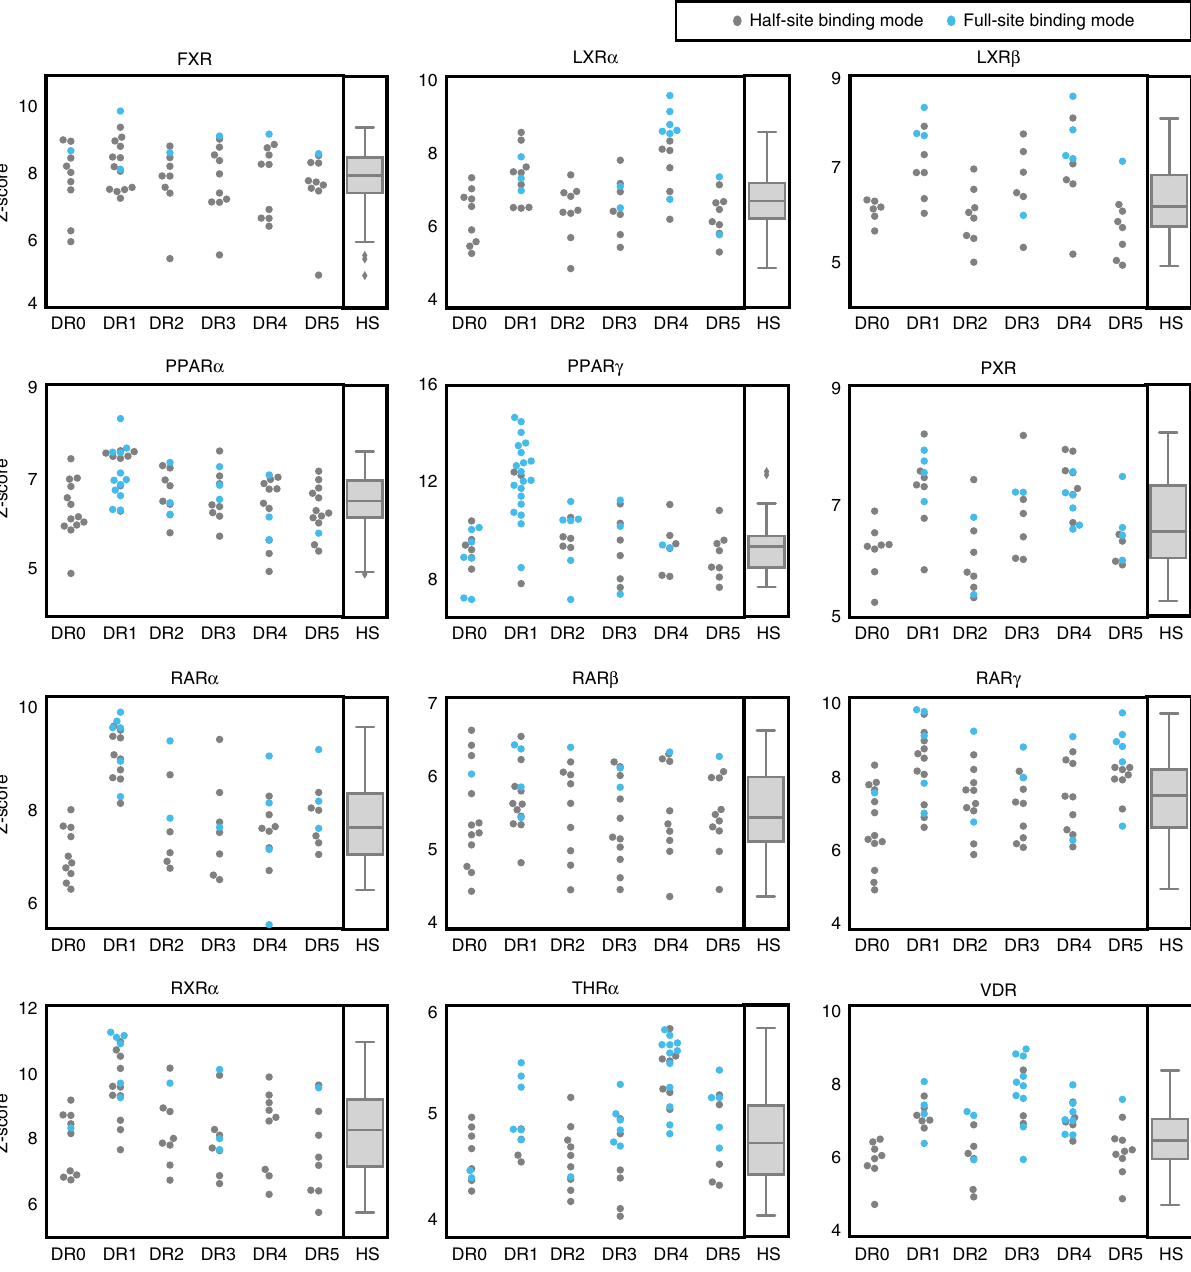
correlation on DR4 sites (R 2 = 0.83) (Fig. 5e). Analysis of the standard DNA-binding logos did not reveal a strong basis for differential DNA-base preferences. However, by directly examin- ing the impact of SNVs on binding via visualization as an energy matrix (which indicates both favorable and unfavorable interac- tions), we see strong differences between PXR and LXR α at positions 10 and 12 (Fig. 5f). The majority of the PXR-speci fi c binding sites are explained by the existence of a guanine base at position 10 that is highly disfavored by LXR α (G10 carries a z- score penalty of − 3.21 for LXR α compared to − 0.47 for PXR).